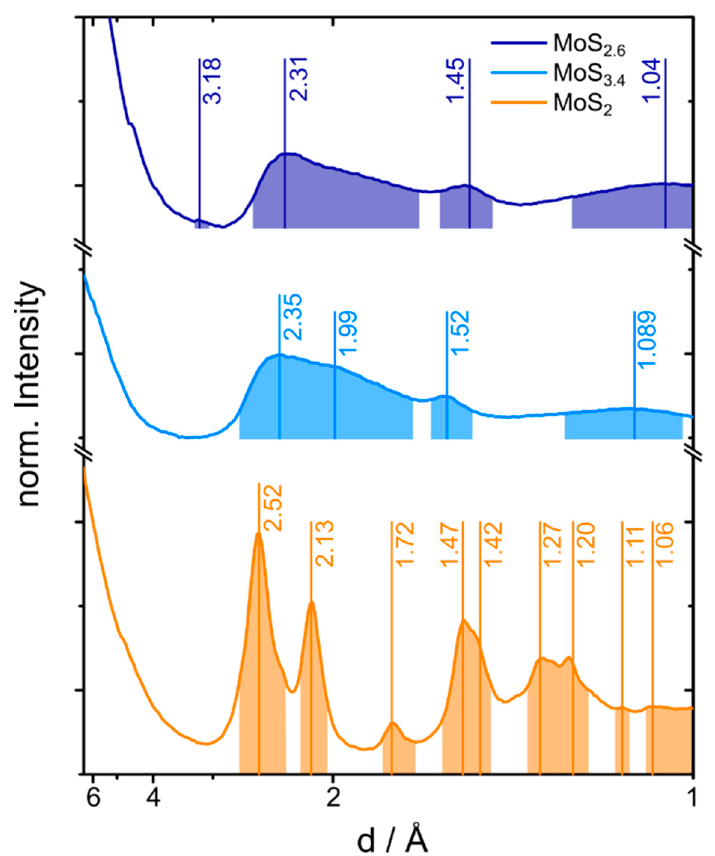
Figure 3. Intensity profiles of the representative electron diffraction patterns of the two MoS 2+ δ batches investigated in this study (MoS 2.6 in dark blue & MoS 3.4 in light blue). Vertical lines indicate the positions of diffraction maxima and the marked areas indicate the width of the reflexes. Note the reflex at ≈ 4.53 Å is most likely an artefact due to the beam stopper.